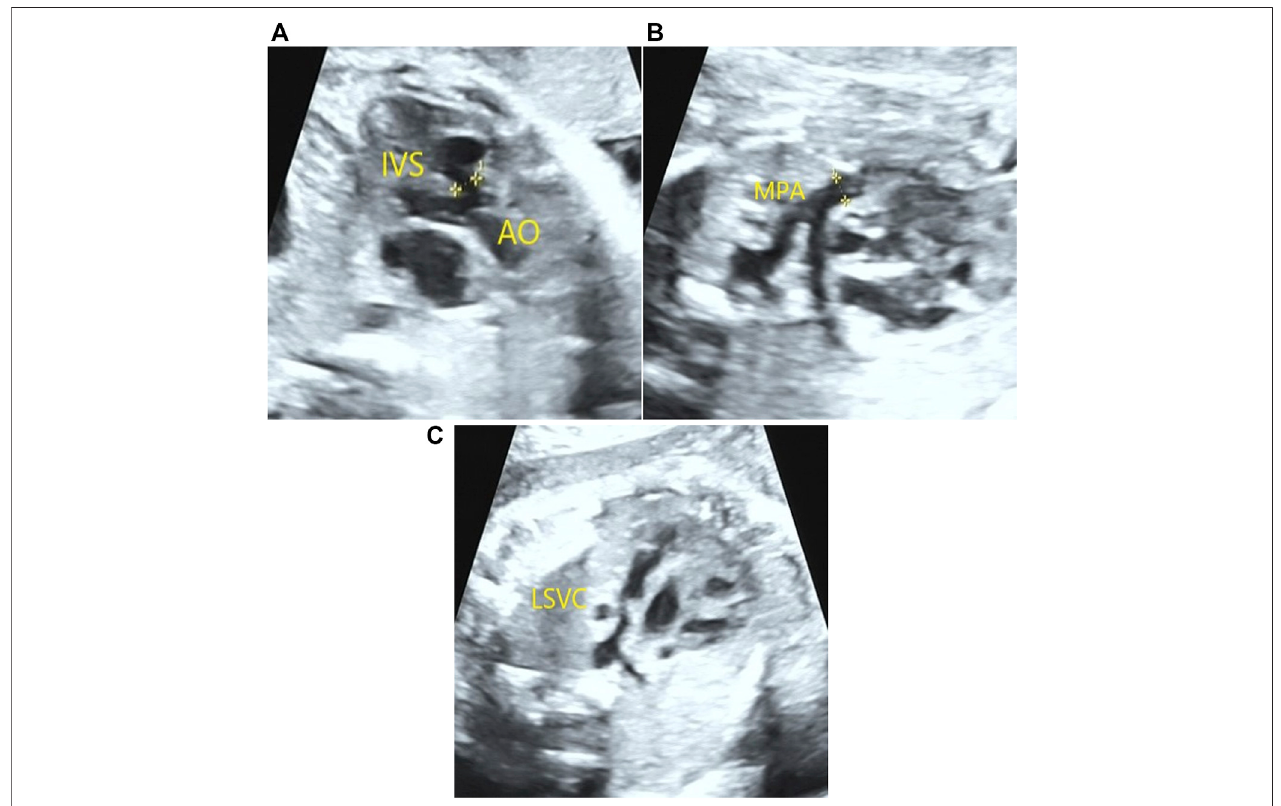
FIGURE 1 | Congenital heart defects detected in the fetus by prenatal ultrasound examination. A 0.41-cm ventricular septal defect and overriding aorta (A) were detected in the fetus by prenatal ultrasound examination. In addition, pulmonary artery stenosis (B) and persistent left superior vena cava (C) were also observed.